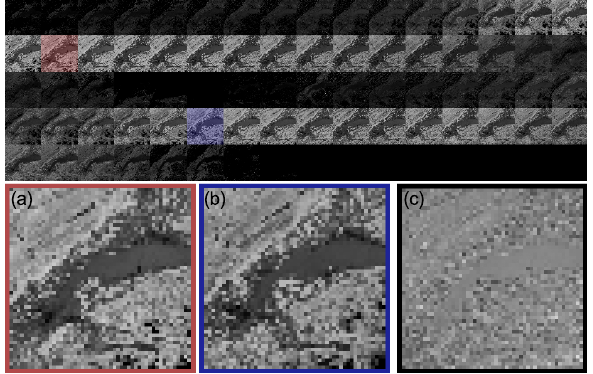
Figure 20. Result after selection from Figure 19: automatic accelerated 2D texture generation in toolbox. As shown with the red and blue samples –zoomed in (a) and (b)–, the direct